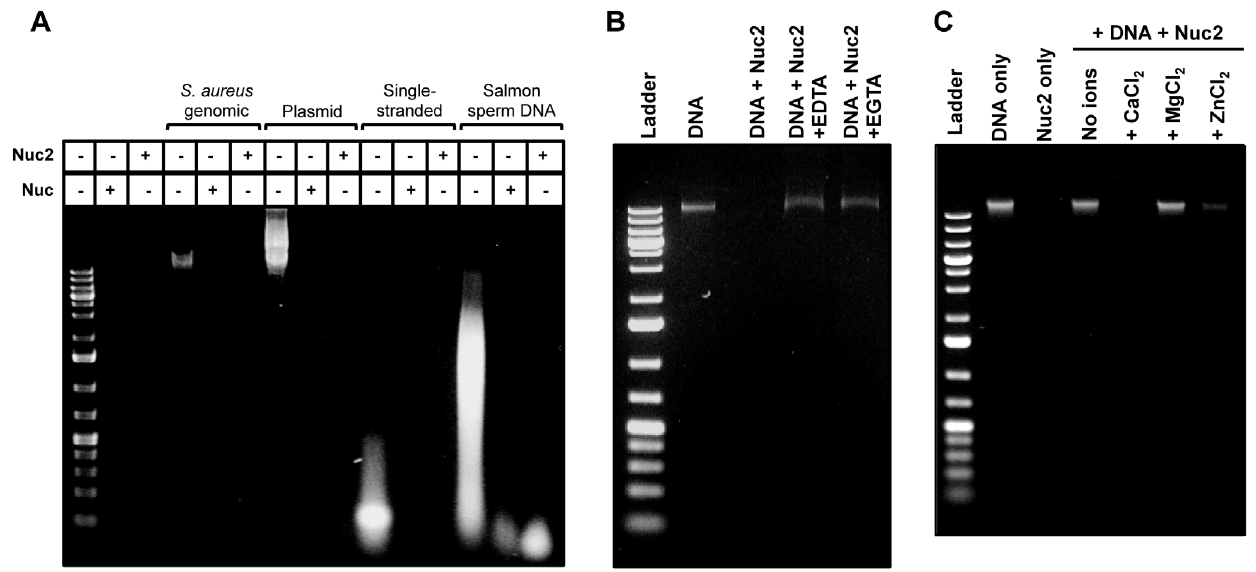
Figure 4. Purified Nuc2 has nuclease activity. Agarose gel degradation assays were performed on a number of different conditions. A . Activity of purified Nuc2 and Nuc against a variety of DNA substrates, including S. aureus and E. coli genomic DNA, single-stranded DNA, plasmid DNA, and eukaryotic DNA. B . Activity of Nuc2 against genomic DNA in the presence of chelators EGTA and EDTA. C . Nuc2 protein was stripped of metal ions and reconstituted with either 10 mM CaCl 2 , MgCl 2 or ZnCl 2 buffers.